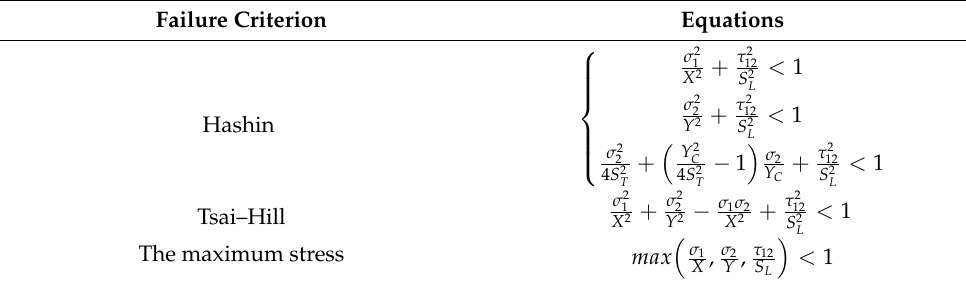
Figure 8. The finite element model for the FDM verification.